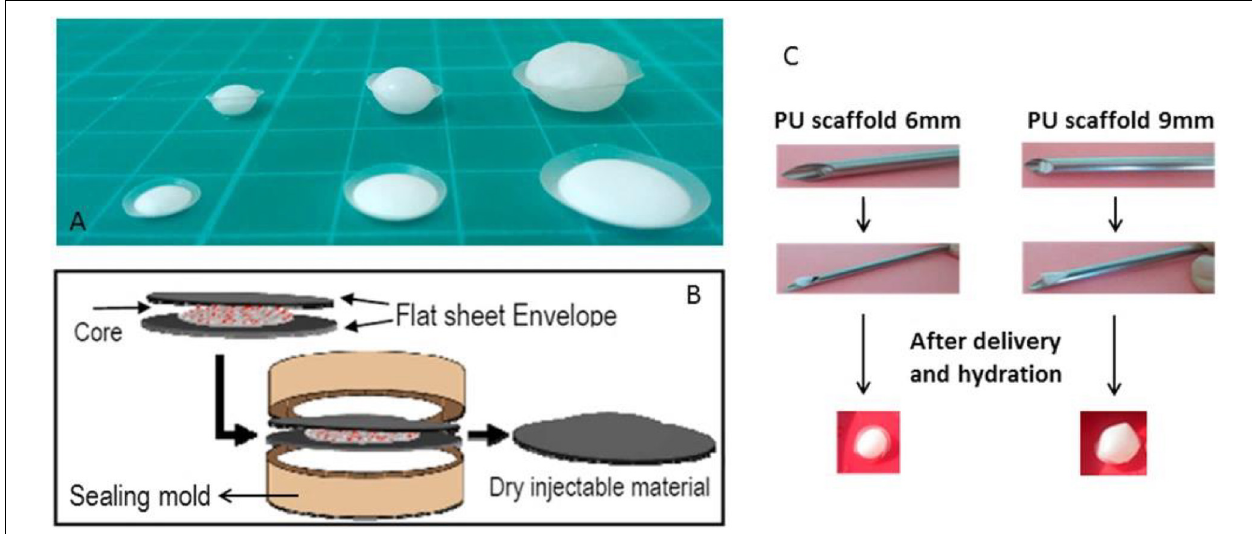
FIGURE 7 | (A) Flat discoid shaped PU scaffold before (front) and after (back) swelling at various sizes. (B) Scheme of PU scaffold assembly process: core disk is wrapped by two envelope disks, and heat sealed within a custom made sealing mold. (C) Non-invasive delivery system for PU scaffold: a demonstration of the scaffold insertion and swelling function after delivery and hydration. Reproduced from Li et al. (2016) with permission from Copyright 2016 Elsevier.